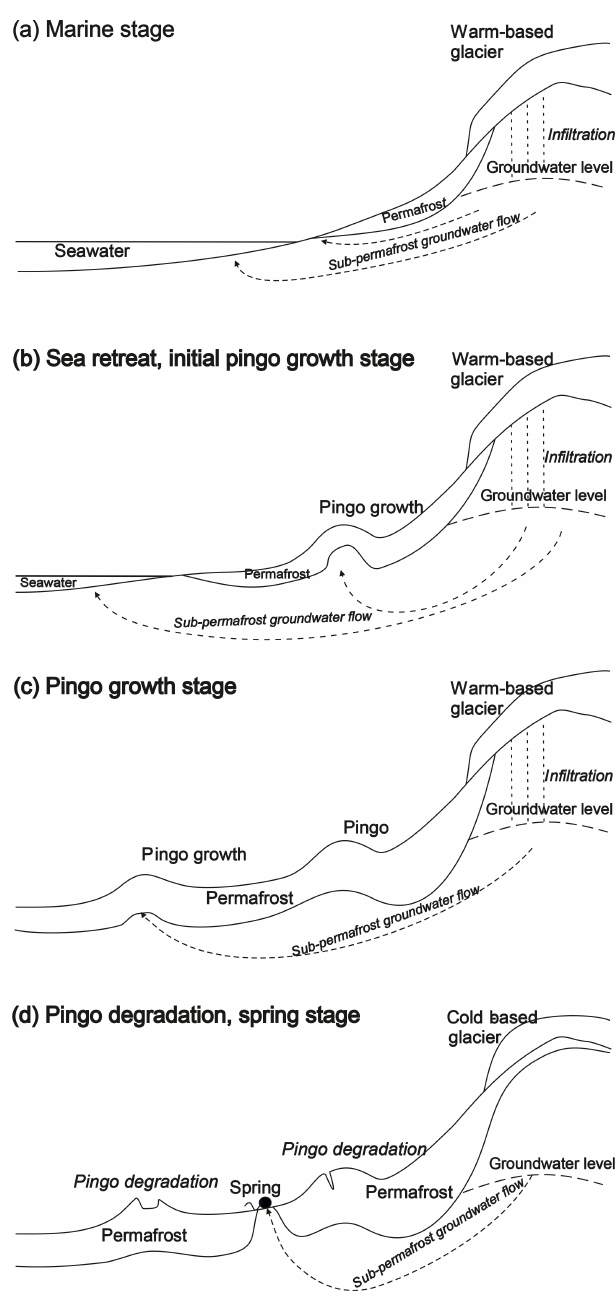
Figure 6. Schematic sketch of Grøndalen evolution and pingo for- mation differentiating into (a) marine stage, (b) initial pingo growth after sea retreat and establishment of the valley’s hydrological sys- tem, (c) continuing pingo growth along the topographic gradient, and (d) current pingo degradation and occurrence of